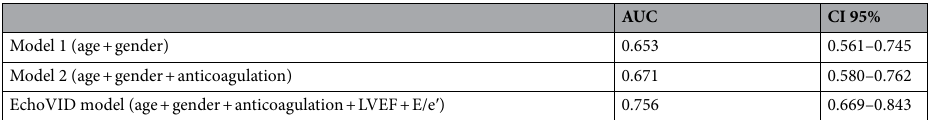
Table 3. Comparison of the discriminative performance of different models for predicting in-hospital mortality in patients with SARS-CoV-2 infection. Values are presented as area under the curve (AUC) and 95% confidence intervals (CI).